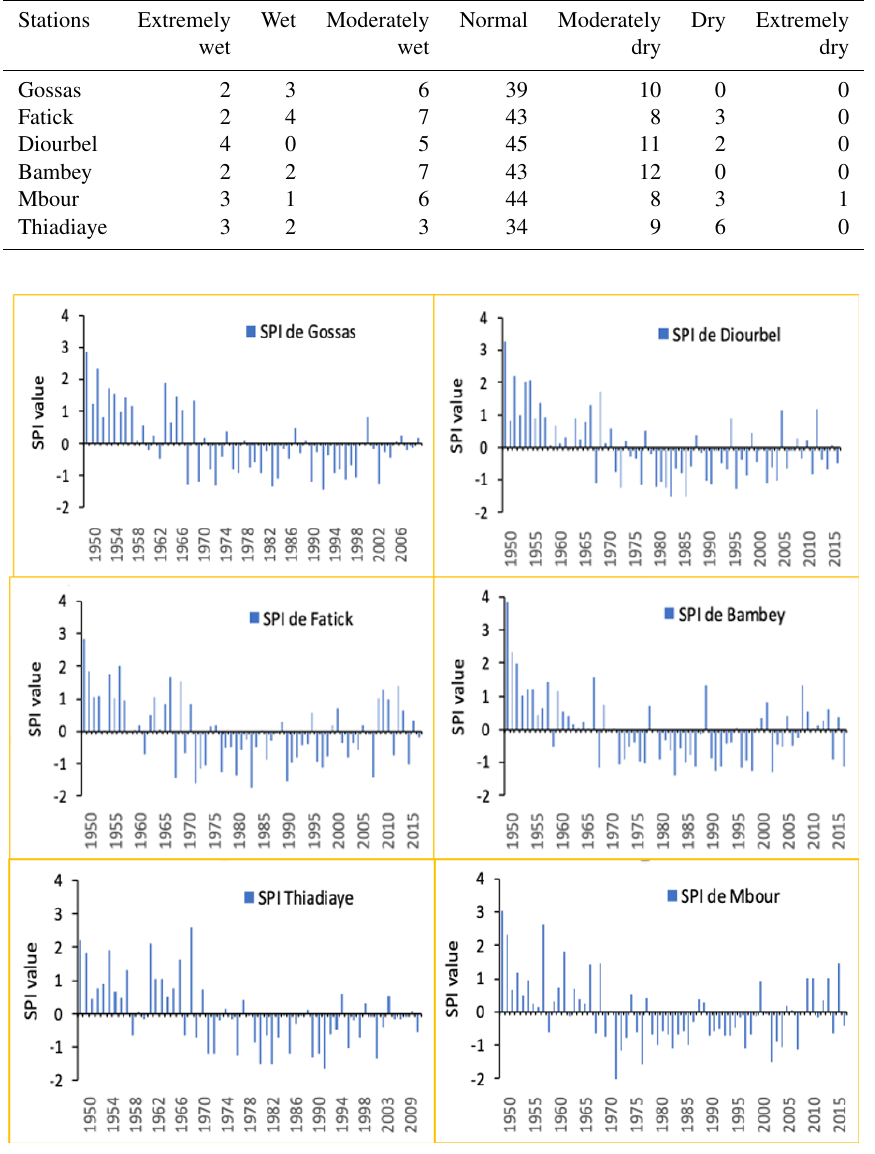
Figure 2. Standard precipitation index (SPI) of the 6 studied rainfall stations, from 1950 to 2009 for Gossas, from 1950 to 2011 for Thiadiaye, and from 1950 to 2016 for Bambey, Fatick, Diourbel and